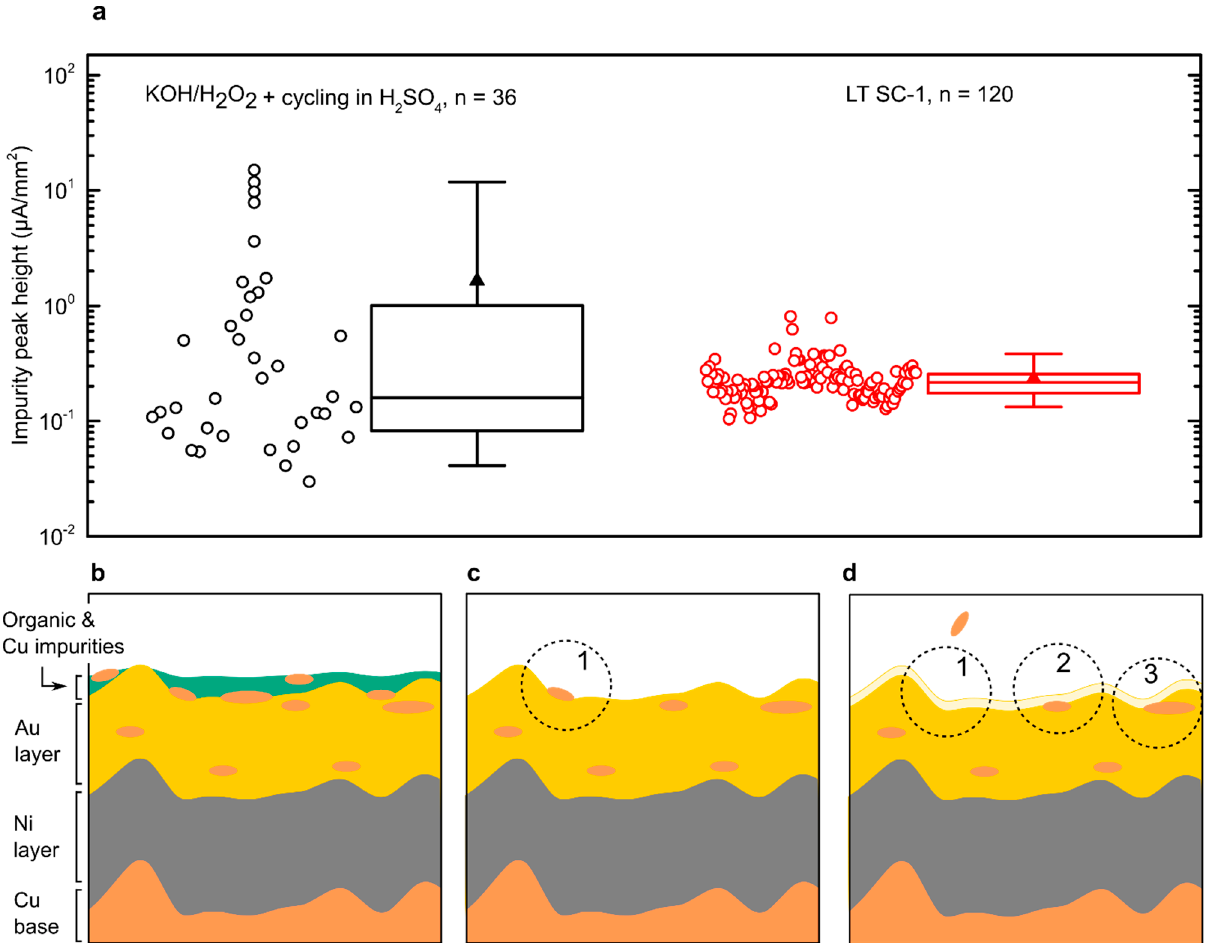
Figure 3. Electroactive impurity peaks in two different cleaning procedures and conceptual representation of PCB impurity removal process. ( a ) The height of impurity peaks in the larger sample number for two promising cleaning procedures. Empty circles represent individual electrodes, lines in a box represent the median, 25th and 75th percentile, the triangle is the mean value, whiskers represent the 5th and 95th percentile. ( b ) Non-treated PCB consisting of layers of a copper base, electroplated nickel, and gold. Cu impurities are found on top of the gold and within the gold layer. ( c ) PCB surface after wet KOH/H 2 O 2 cleaning with removed organic and inorganic impurities. ( d ) Removal of the thin gold layer during CV cycling. Circle 1 represents the removal of Cu impurity and circles 2 and 3 represent newly formed exposure of the hidden Cu impurities within the plated electrodes.